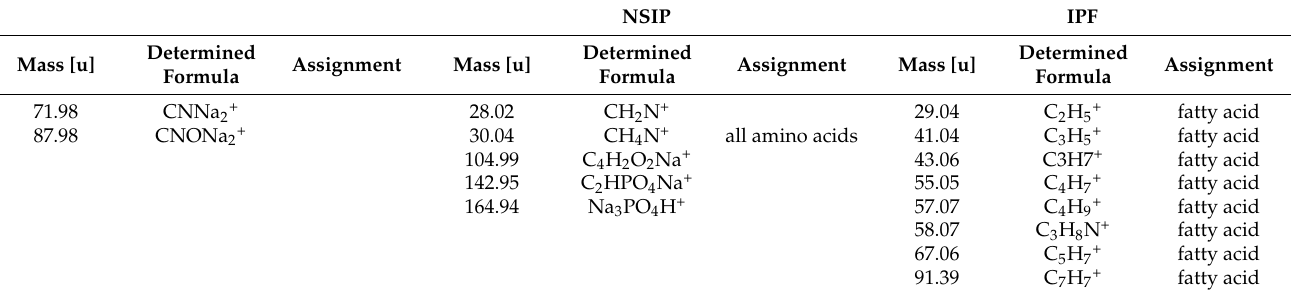
Table 2. The most characteristic ToF-SIMS signals for each cell line (Procedure I), revealed by loadings plot analysis. NSIP IPF